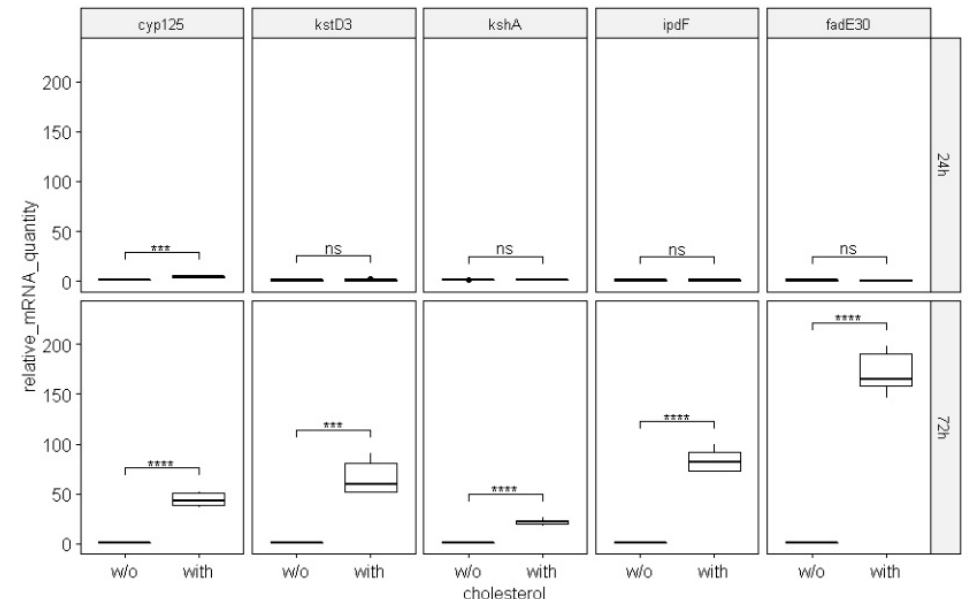
Figure 7. Relative mRNA quantities of the five genes of interest (normalized to the 16S rRNA amount) at 24 and 72 h of cholesterol induction. Designations: w/o, without; ns, p > 0.05; (***), p ≤ 0.001; (****), p ≤ 0.0001.